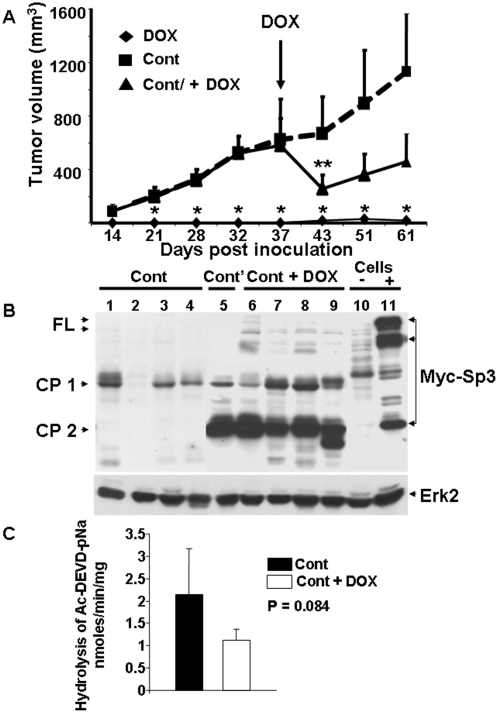
Sp3 prevents tumour formation in nude mice.A) Nude mice were inoculated with cells conditionally expressing Sp3 (LS174 clone S27). Comparison of the size of the tumours in animals receiving doxycycline in drinking water (DOX) or normal water (Cont). 37 days following inoculation, half of the control mice were treated with doxycycline (Cont+DOX). Tumour size was measured at the indicated times and tumour volume was calculated and plotted±SD. Statistically significant differences (p<0.05) between controls and doxycycline treated mice (*, immediate treatment after inoculation; **, treatment after development of the tumours) are indicated. B) Analysis by western blot with a Myc-directed antibody of extracts from tumours that have grown without tetracycline (Cont, lanes 1 to 4), a tumour that had grown in the presence of tetracycline (Cont', lane 5) and from tumours that had re-grown after tetracycline treatment of control tumours (Cont+DOX, lanes 6 to 9). Myc-tagged Sp3 expression was also analysed in S27 cells (Cells) treated (+, lane 11) or not (−, lane 10) by tetracycline. Arrows indicate the position of the full-length (FL) and cleaved Sp3 fragments (CP 1 and CP 2). Erk2 is shown as a loading control. C) Pan-caspase activity was measured in control tumours (Cont, black histogram) and in tumours that have grown in the presence of doxycycline (Cont+DOX, white histogram). Plotted is the specific caspase activity (total activity minus the values in the presence of 50 µM Z-VAD-FMK) measured as indicated in materials and methods. Results are the mean of three independent measurements of the individual tumour extracts.